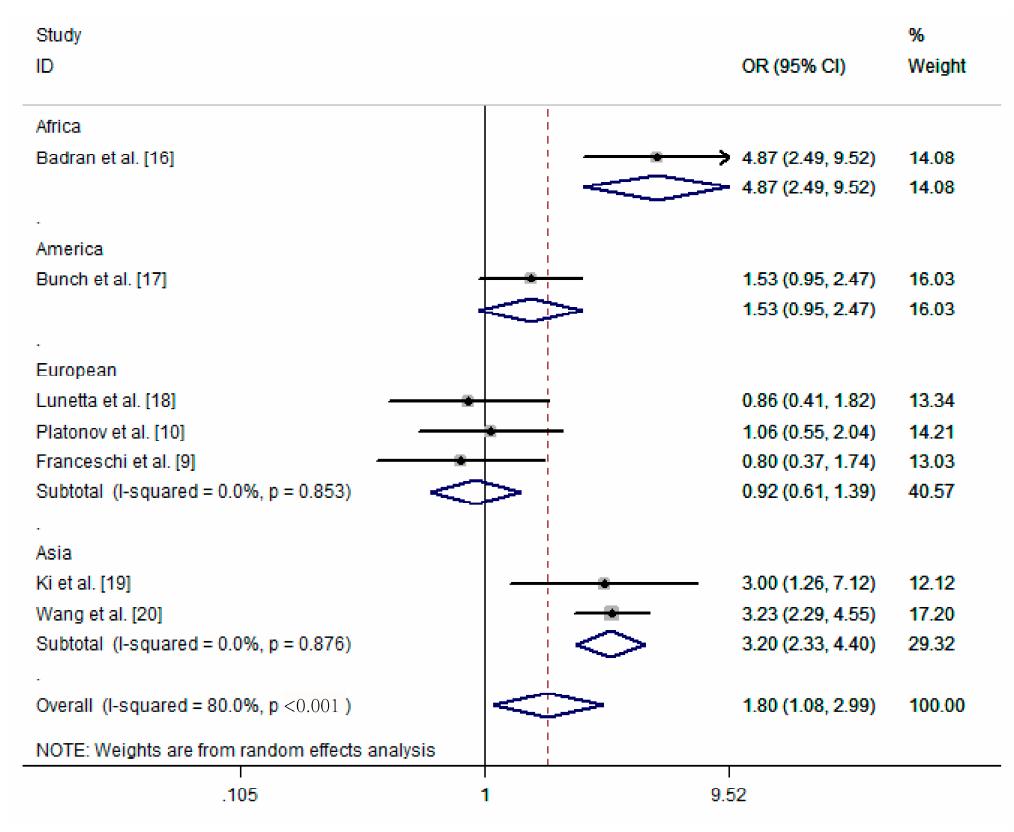
Figure 4. Forest plot showing the relationship between arrhythmia and Helicobacter pylori infection: studies divided into subgroups according to the continent of study origin. OR, odds ratio; CI, confidence interval.